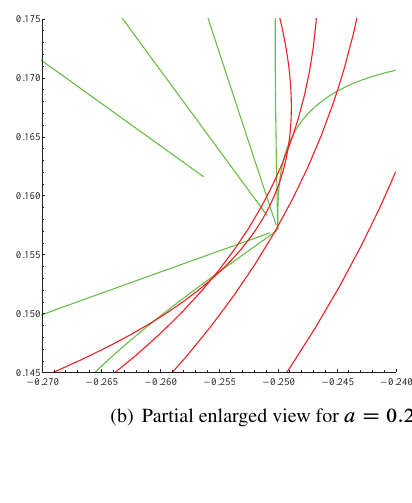
Fig. 2. Images of U under f 0 (cid:3) f for various values a